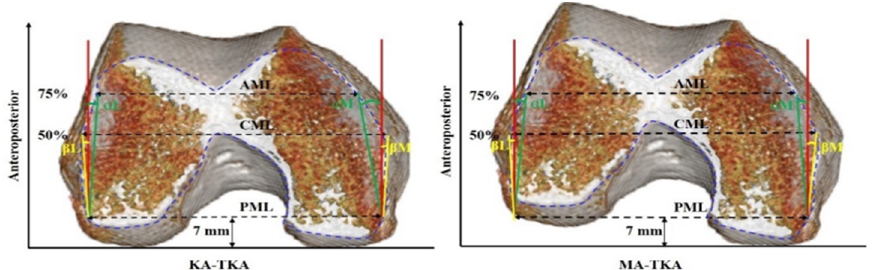
Figure 3. Transverse CT slice at the level of the distal cutting of the femur, indicating the femoral cortical contours (blue). The posterior medial-lateral (PML) width was the posterior femoral condylar cutting width, the central medial-lateral (CML) width was measured at 50% AP, and the anterior medial-lateral (AML) width was measured at 75% AP. Lateral narrowing: α L and β L; medial narrow- ing: α M and β